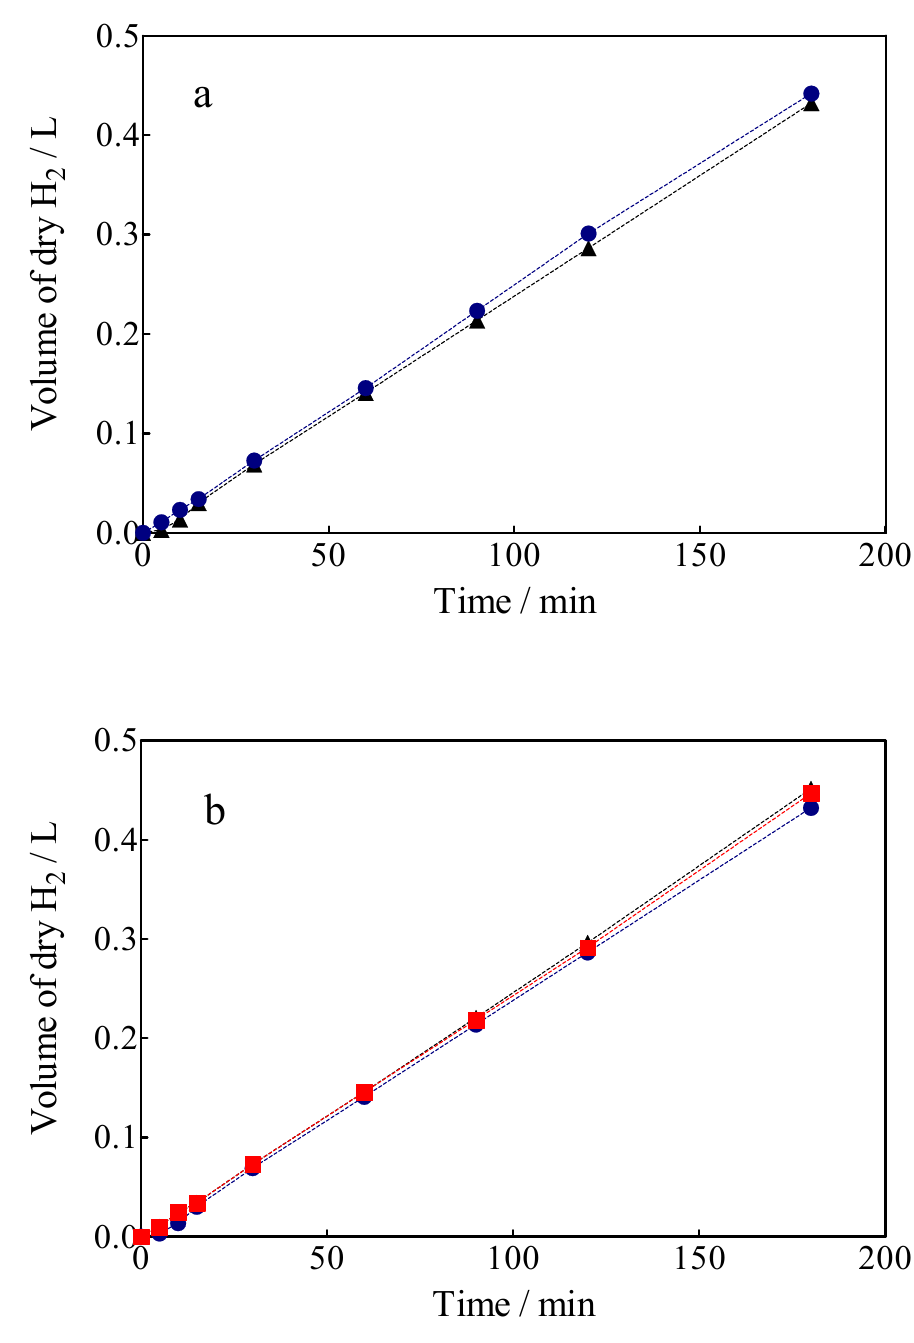
Figure 11. The amount of H 2 obtained vs electrolysis time by applying 15 mA cm − 2 : ( a ) 0.05M Na 2 SO 4 + 20 mg L − 1 (black circle) or 50 mg L − 1 (blue circle) of Calcon dye, ( b ) different flow rate in the anodic compartment (( ● ) 10, ( ■ ) 39 and ( ▲ ) 90 mL min − 1 ).